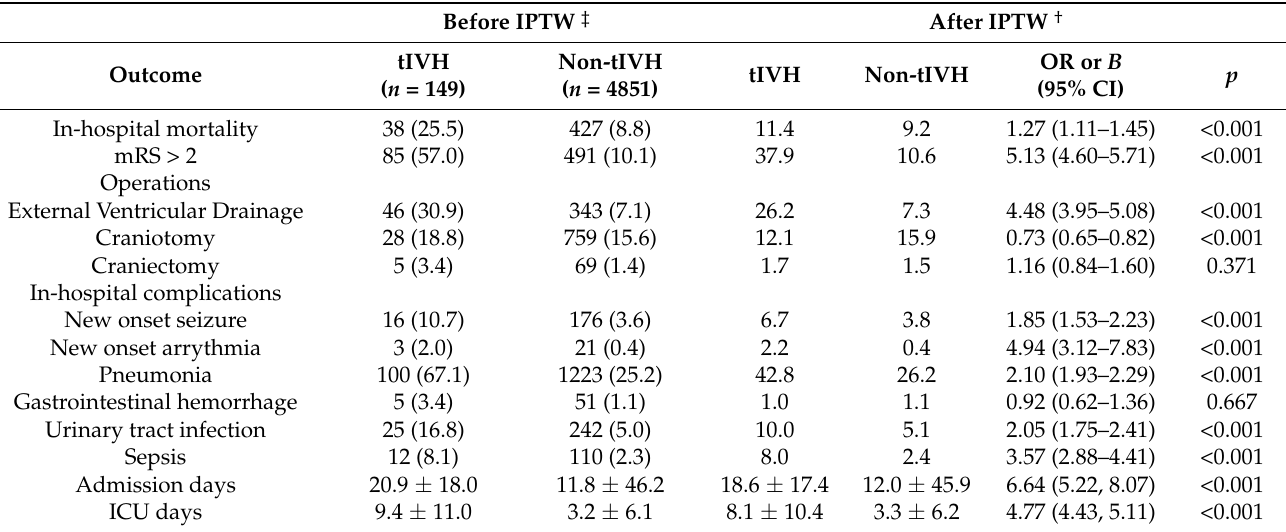
Table 2. Association between the presence of tIVH and outcomes ( n =